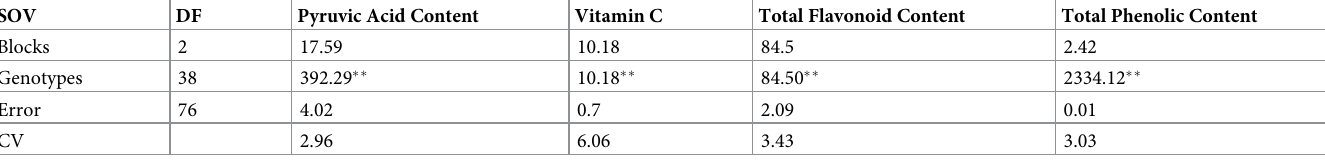
Table 3. Analysis of variance showing significant differences among 39 onion genotypes for nutraceutical traits.